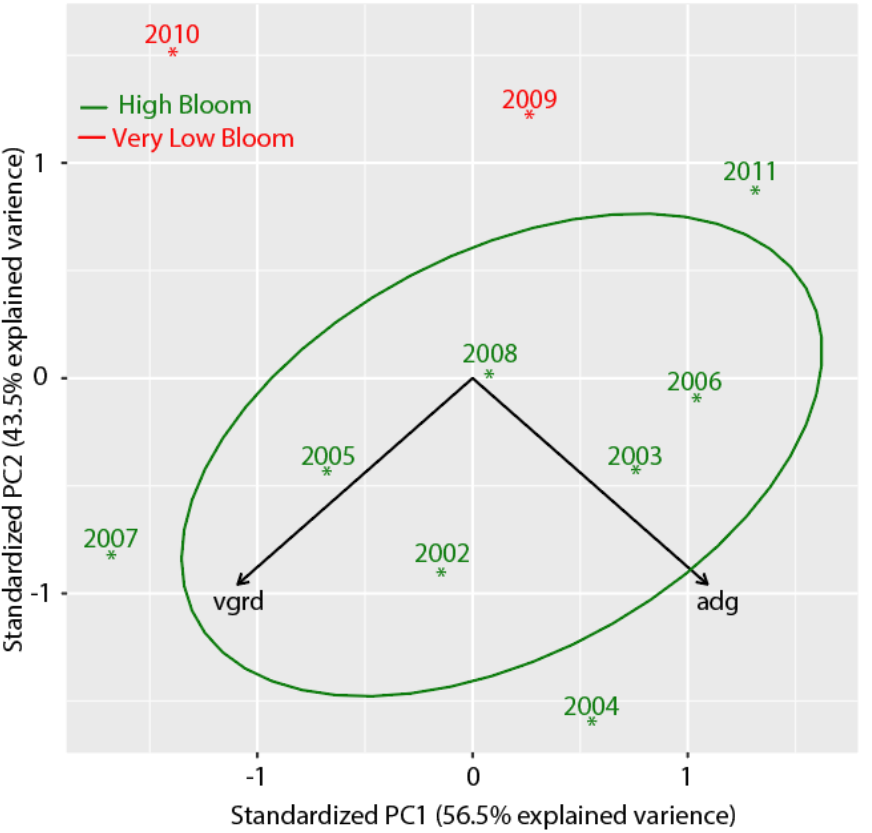
Figure 11. Principal Components Analysis (PCA) by year (2002–2011) physically separating very low bloom years (2009 and 2010; as having CI cyano values near zero) shown in red, from other years (2002 – 2008, 2011; as having CI cyano values near 1), shown in green, in Green Bay. The two input parameters that resulted in the greatest separation were v-wind and adg.